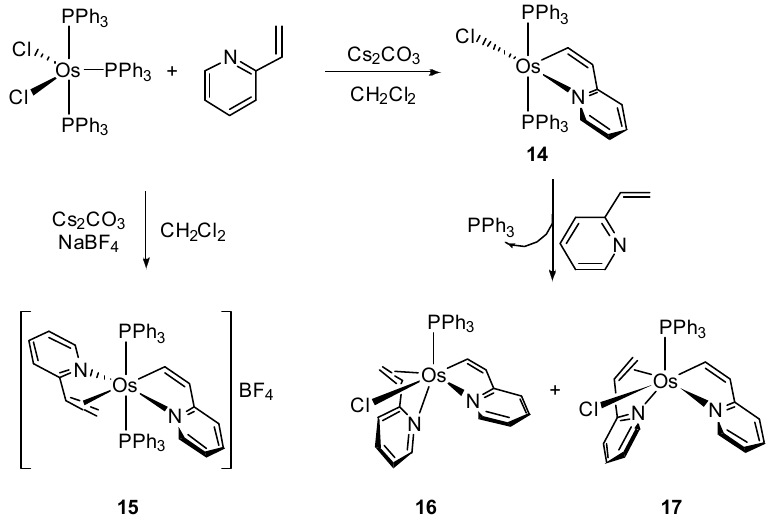
Figure 4. Cyclometalated complexes derived from 2-vinylpyridine.